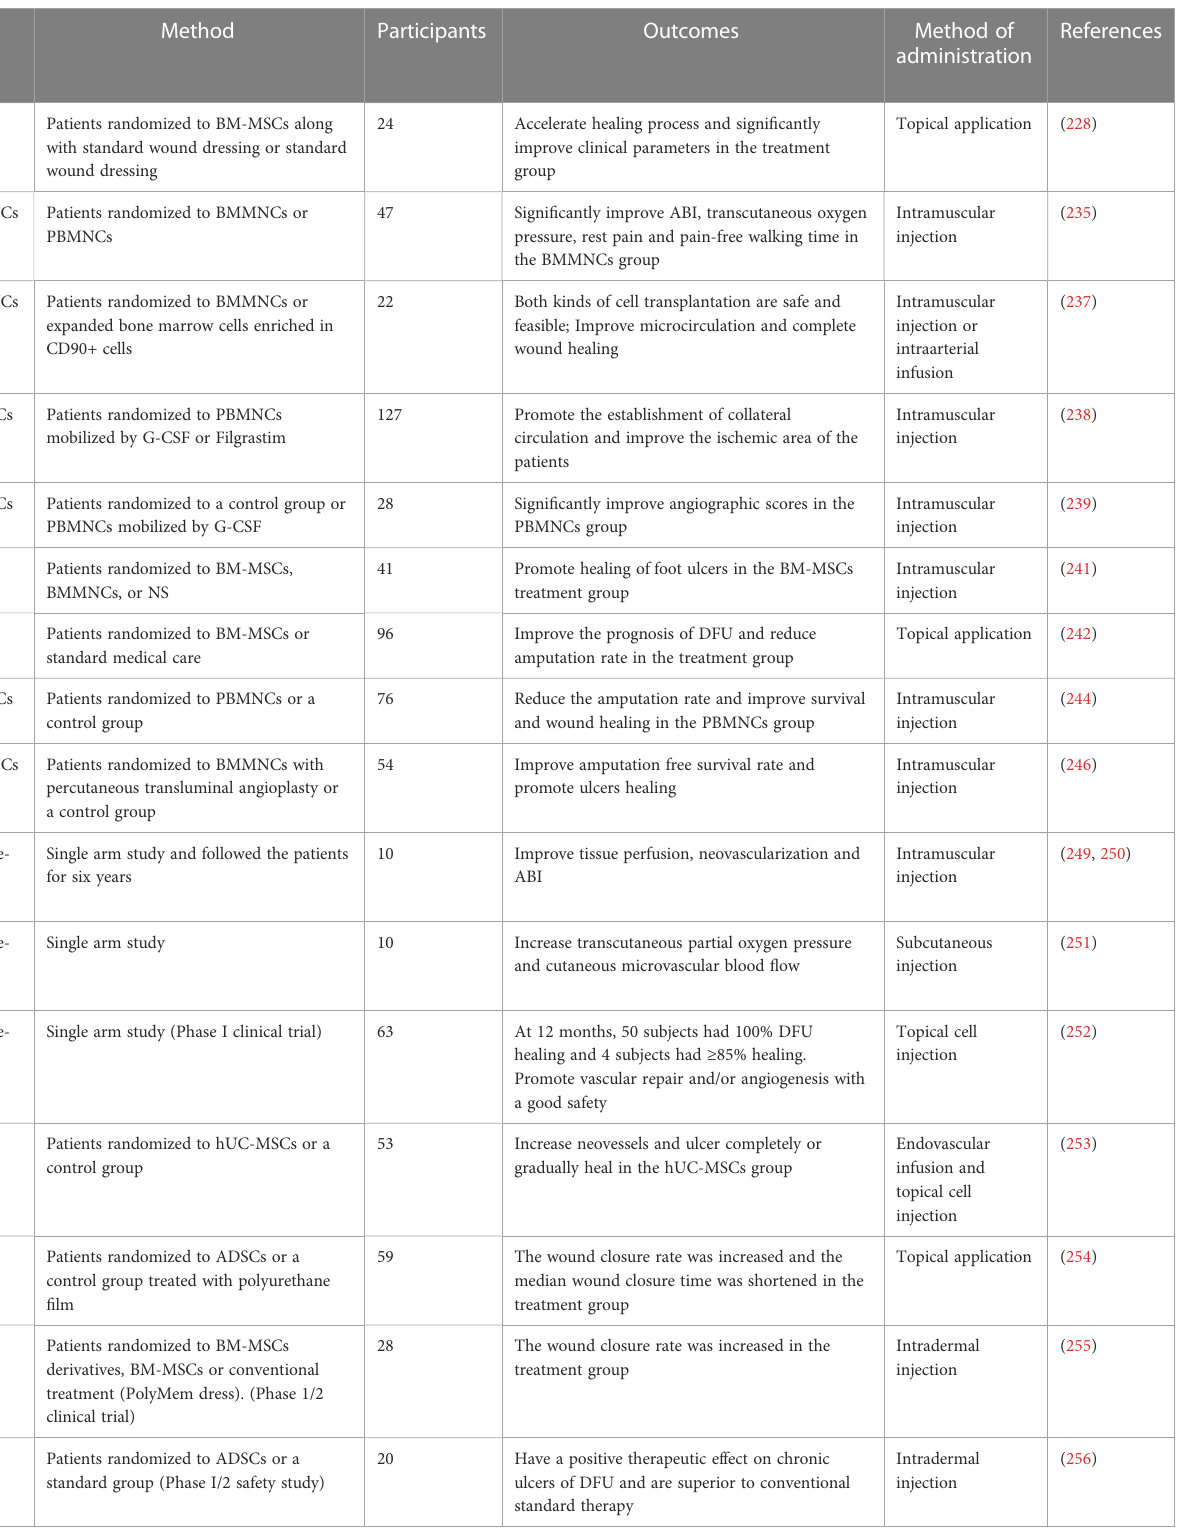
TABLE 2 MSCs treatment of diabetic foot related clinical